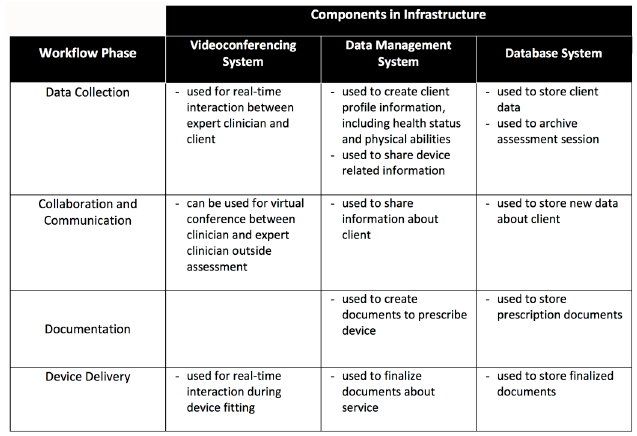
Table 1. Matrix of Phases and